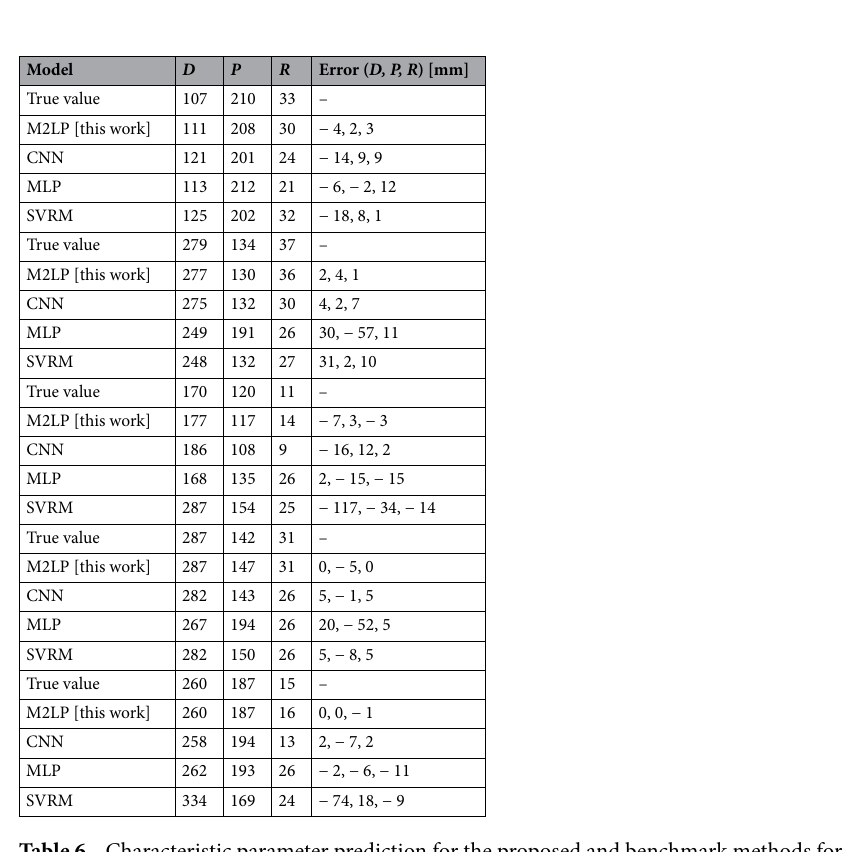
Table 6. Characteristic parameter prediction for the proposed and benchmark methods for selected test scenarios.